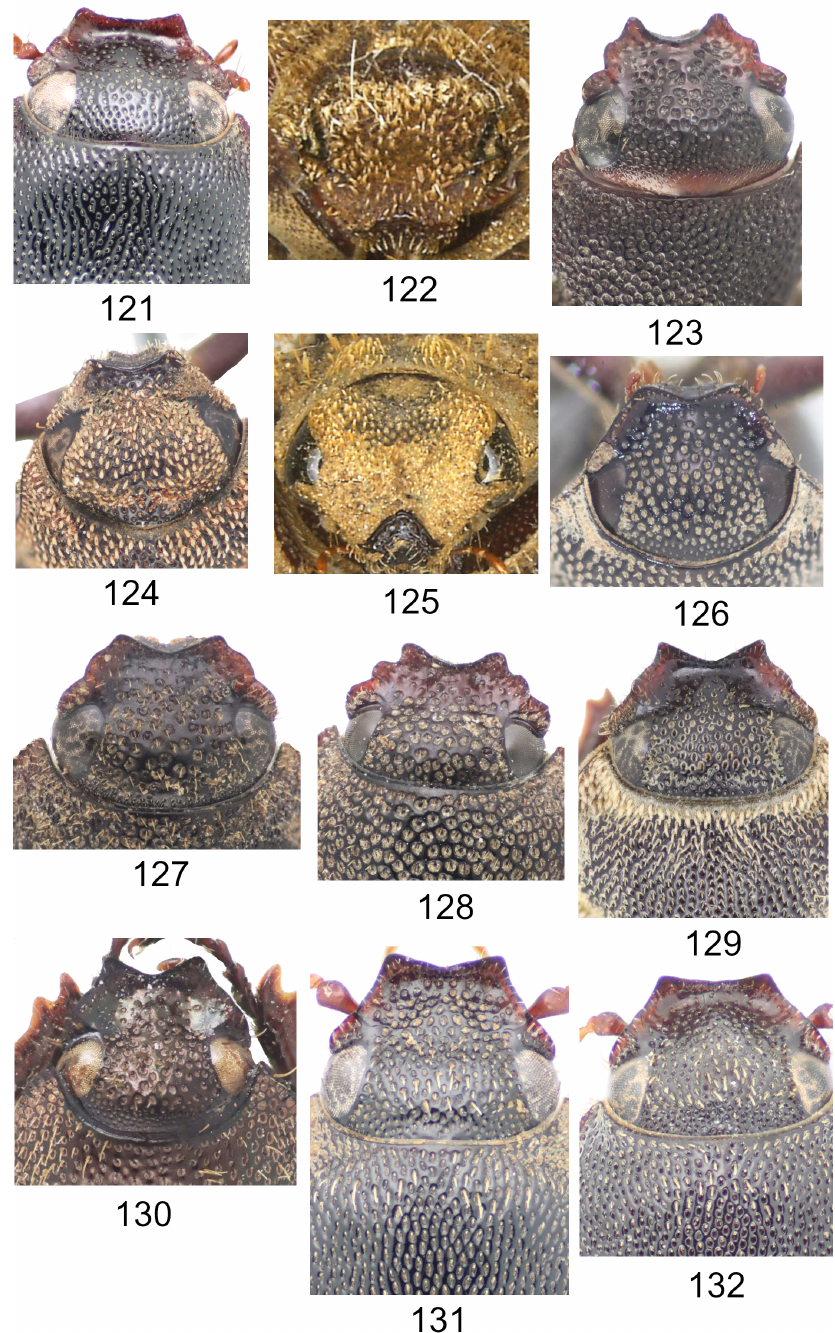
Figs 121–132. Papuan, Wallacean and Oriental Maechidius Macleay, 1819, head, dorsal (121, 123–124, 126–132) and frontal (122, 125) views. 121 . M. hamatus sp. nov., holotype, ♂ (IECA). 122 . M. helleri (Frey, 1969) comb. nov., holotype, ♂ (photograph courtesy BPBM) (BPBM). 123 . M. hirtipes Arrow, 1941, lectotype, ♂ (BMNH). 124 . M. heterosquamosus Heller, 1910 comb. rest., lectotype, ♀ (SNSD). 125 . Same, ♂, holotype of M. clypeatus (Frey, 1969) comb. nov. (BMNH). 126 . M. interruptocarinulatus Heller, 1914, holotype, ♀ (SNSD). 127 . M. humeralis Heller, 1914, lectotype, ♂ (SNSD). 128 . Same, paralectotype, ♀ (SNSD). 129 . M. kazantsevi sp. nov., holotype, ♂ (BMNH). 130 . M. jobiensis Moser, 1920, lectotype, ♂ (ZMHB). 131 . M. konjo sp. nov., holotype, ♂ (NMPC). 132 . M. leucopsar sp. nov., holotype, ♂ (IECA). Not to